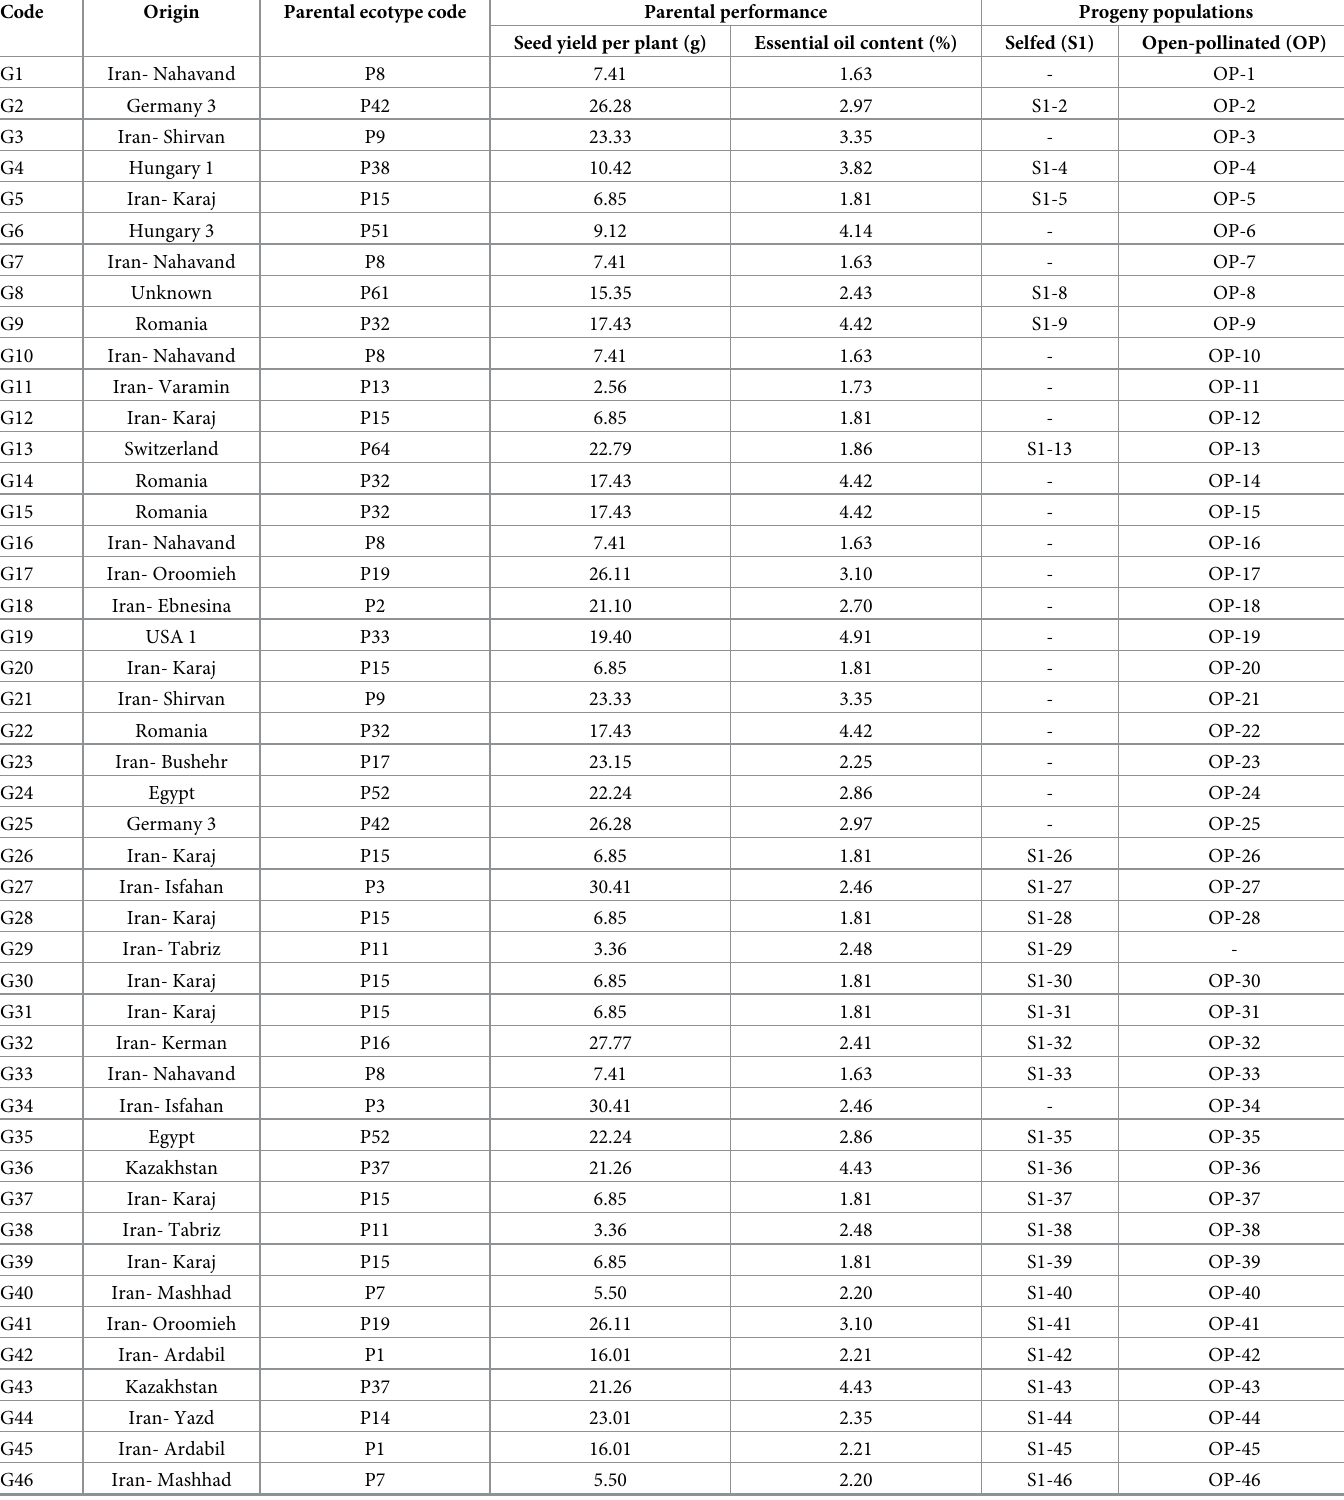
Table 1. Information of fennel genotypes used in the